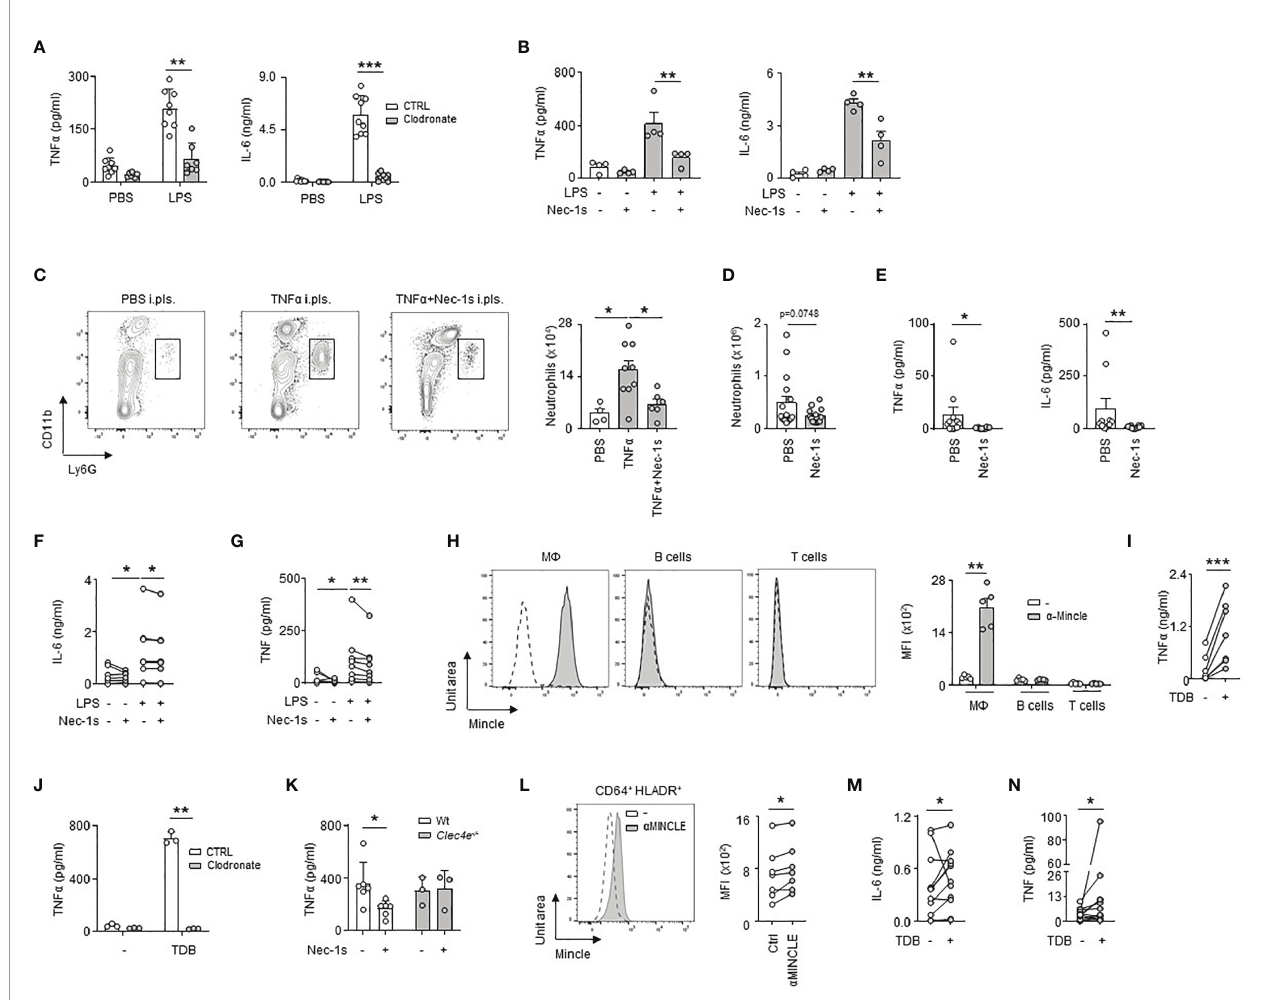
FIGURE 5 | Necroptotic pleural resident macrophages promote pleural space in fl ammation upon bacterial pneumonia. (A) Levels of TNF a and IL-6 in culture supernatant of pleural cells depleted (clodronate) or not (CTRL) of RM 24h after ex vivo stimulation with LPS. Mice received i.pls. injection of liposome control (CTRL) or clodronate (Clodronate) 2 days before harvesting pleural cells (n=7-9). (B) Levels of TNF a and IL-6 in culture supernatant of pleural cells from WT mice 24h after ex vivo stimulation with LPS (2µg/ml) and/or Nec-1s (50µM) (n=4 mice). (C) Representative dot plots and enumeration of neutrophils in pleural space 24h after i.pls. injection of 100ng of recombinant TNF a with and without i.pls. injection of 100µg of necrostatin-1s (n=4-9). (D) Enumeration of neutrophils in pleural space 24h after i.t. infection of 5x10 6 CFU of E. coli and i.pls. injection of 100µg of necrostatin-1s (Nec-1s) or PBS (PBS) (n=10 mice). (E) TNF a and IL-6 levels in pleural space 24h after i.t. infection of 5x10 6 CFU of E. coli and i.pls. injection of 100µg of necrostatin-1s (Nec-1s) or PBS (PBS) (n=8-10 mice). (F, G) Levels of IL-6 (F) and TNF (G) in the supernatants of human PEF cells stimulated for 24h with LPS and/or Nec-1s (n=8 out of 24). (H) Representative histogram and mean fl uorescence intensity (MFI)